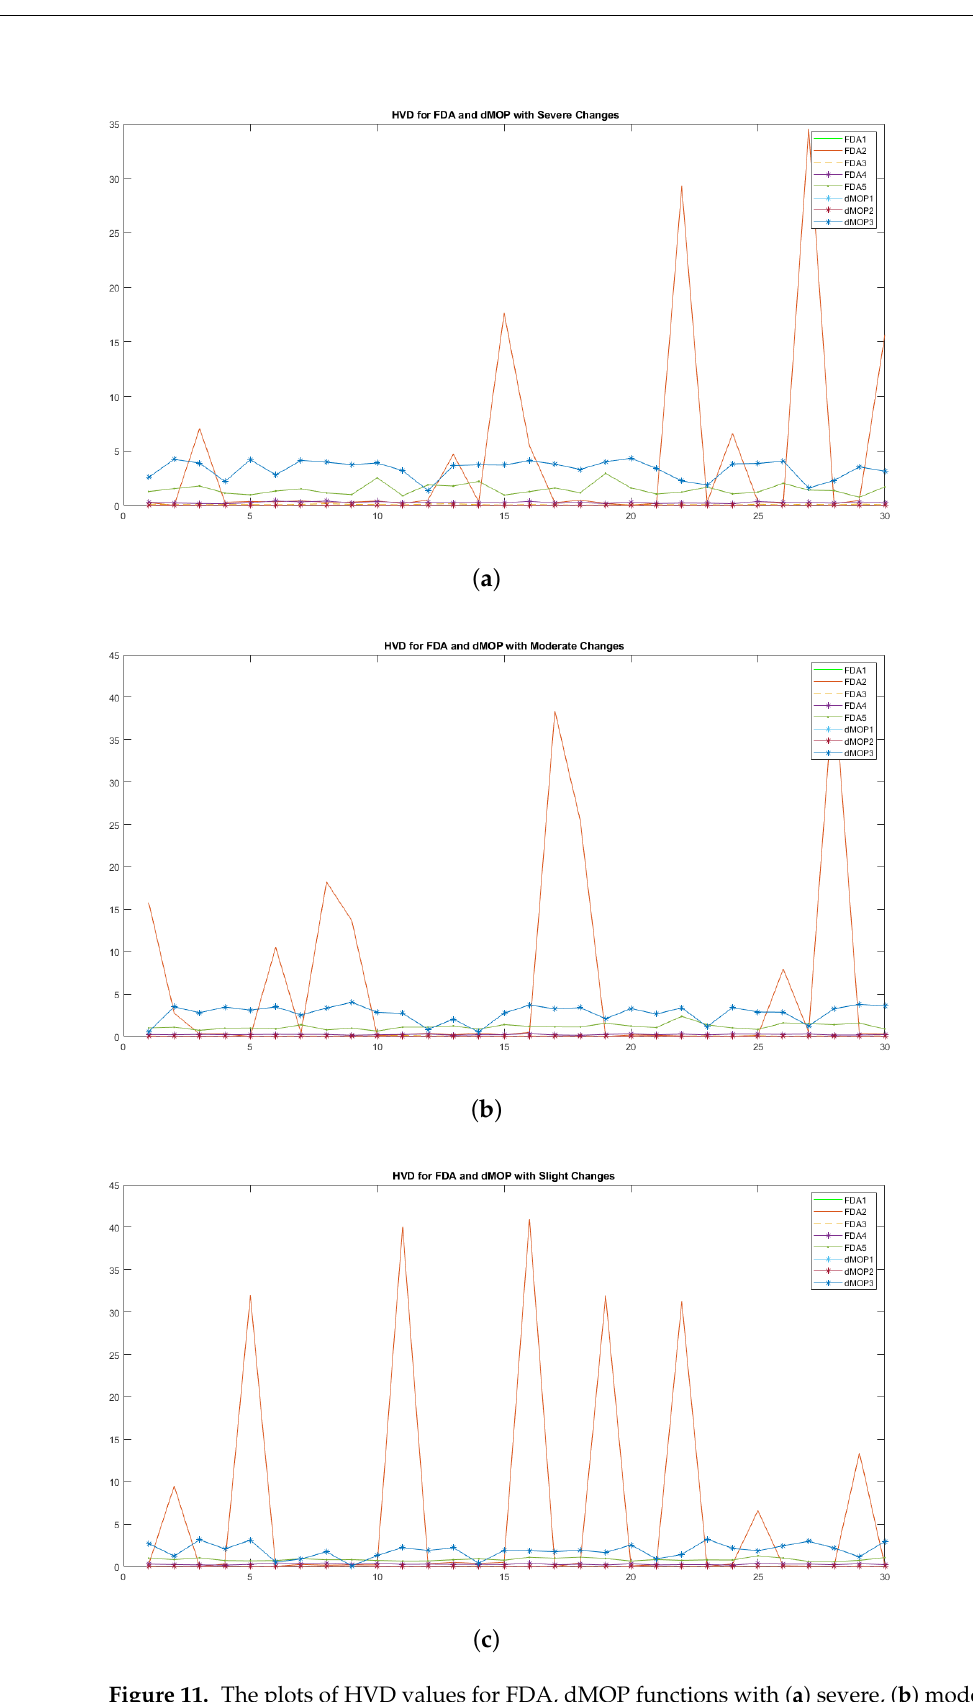
Figure 11. The plots of HVD values for FDA, dMOP functions with ( a ) severe, ( b ) moderate and ( c ) slight environmental changes using the DB-CSA